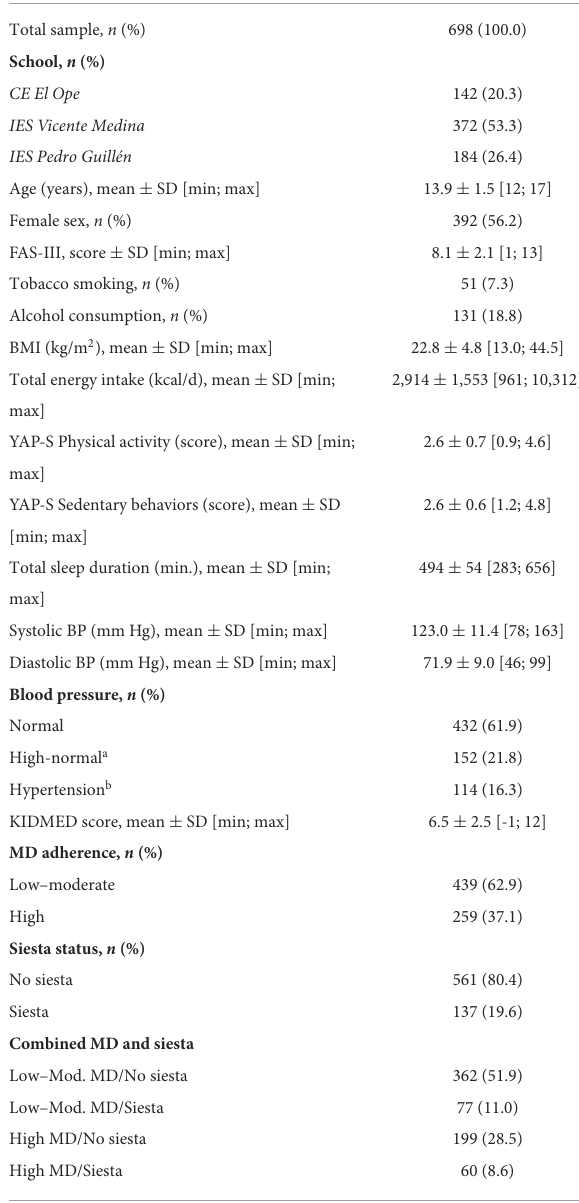
TABLE 1 Characteristics of study